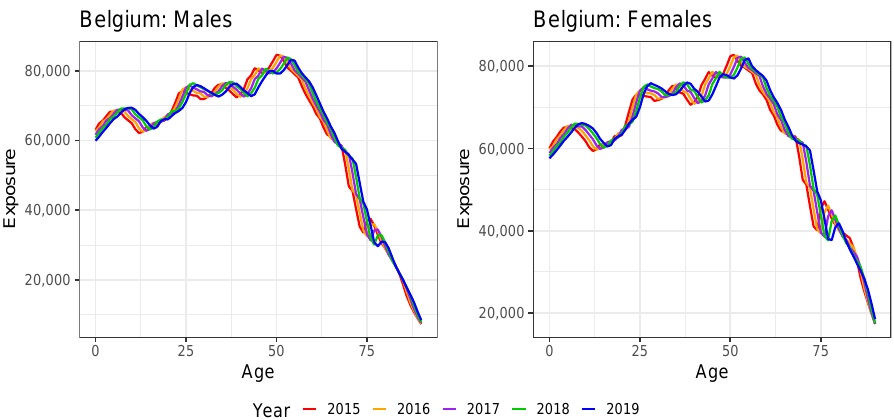
Figure A1. The exposures E x , t of Belgium for ages 0–90 and years 2015–2019. Data from HMD until the year 2018 and from Eurostat for the year 2019.